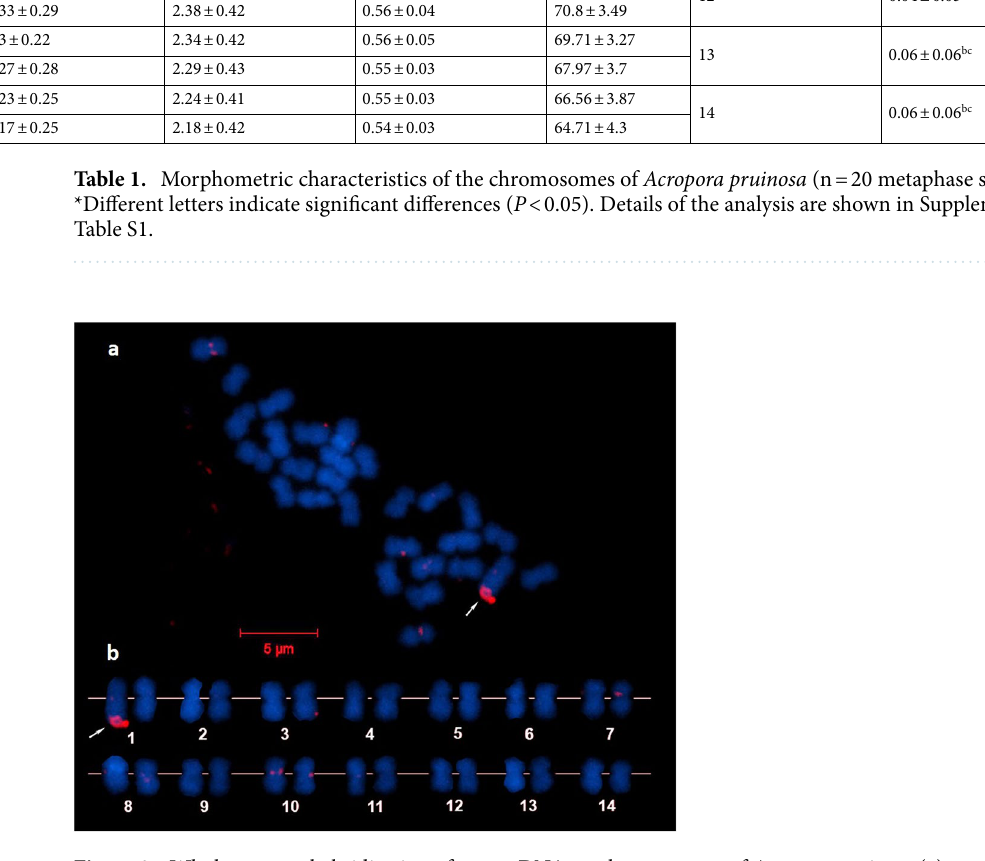
Figure 2. Whole genome hybridization of sperm DNA on chromosomes of Acropora pruinosa ( a ). Chromosomes arranged in order of decreasing length ( b